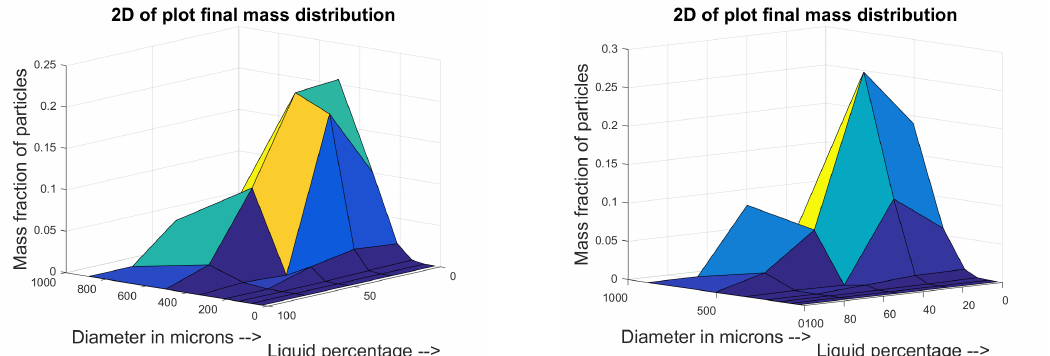
Figure 3. 2-dimesional mass frequency of particles with respect to both diameter and moisture